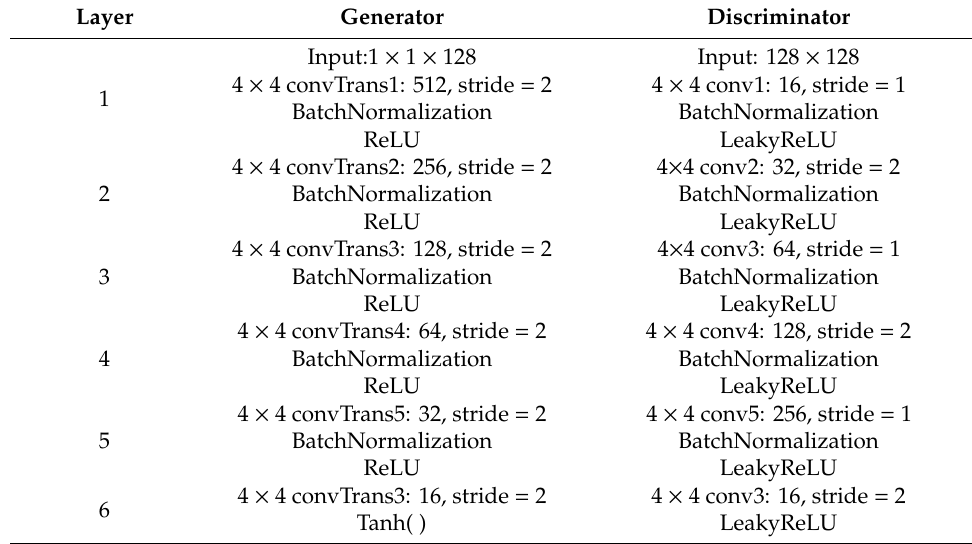
Table 3. Configuration of DCGAN; 4 × 4 conv1 represents the size of the first layer of convolution kernel and 512 represents the size of the output feature map. Layer Generator Discriminator Input:1 × 1 ×